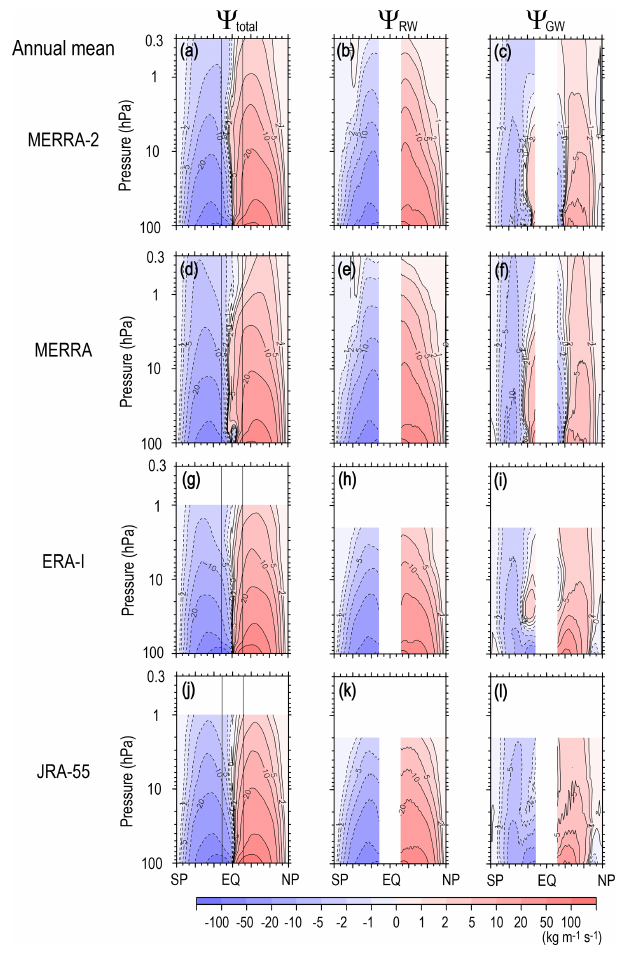
Figure 2. Meridional cross sections of the climatology of the annual mean stream function of the residual mean flow (a) , and contribu- tions of RWs (resolved waves) (b) and GWs (unresolved waves) (c) for MERRA-2, for MERRA (d–f) , for ERA-Interim (g–i) , and for JRA-55 (j–l)